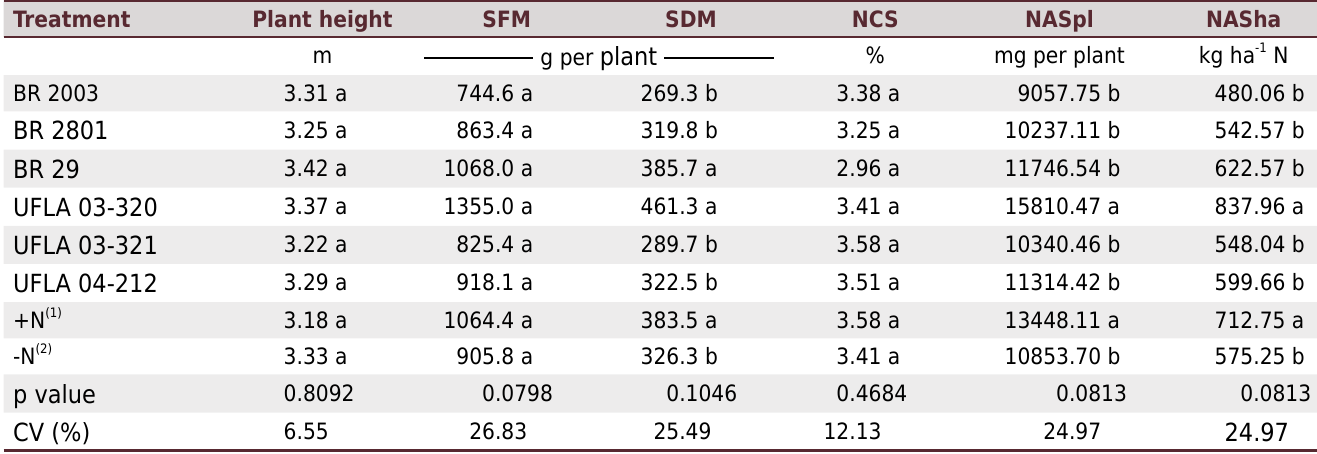
Table 6. Plant height, shoot fresh matter (SFM), shoot dry matter (SDM), nitrogen content in the shoot (NCS), and nitrogen accumulation in the shoot per plant (NASpl) and per hectare (NASha) of pigeon pea cv. IAC Fava-Larga cultivated in the field